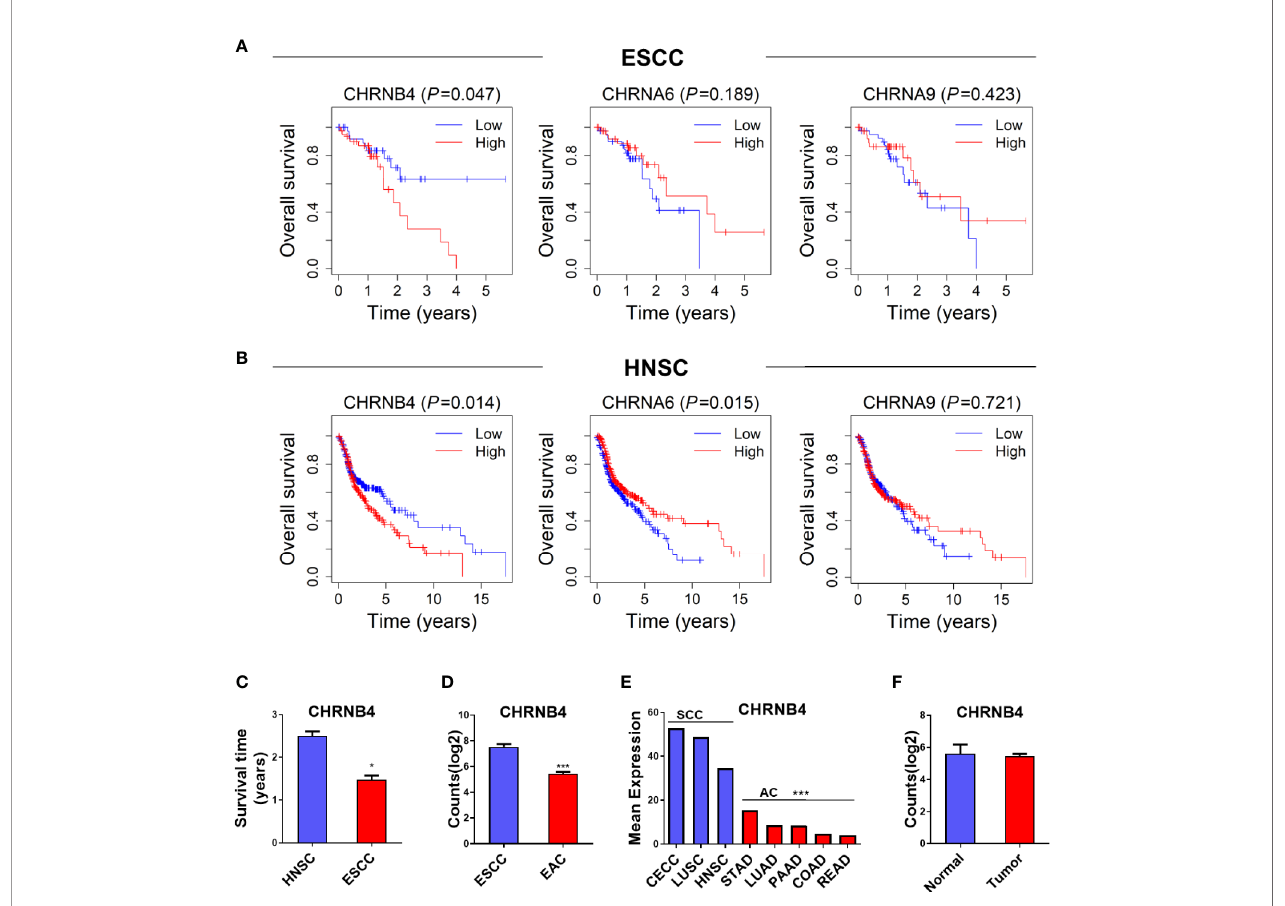
FIGURE 2 | (A, B) Survival analysis of 3 CHRN family genes in ESCC, HNSC. (C) The survival time between HNSC and ESCC patients. (D, E) The expression situation of CHRNB4 in several SCCs and ACs. (F) The expression of CHRNB4 between normal and tumor in EAC. *** P < 0.001; * P <